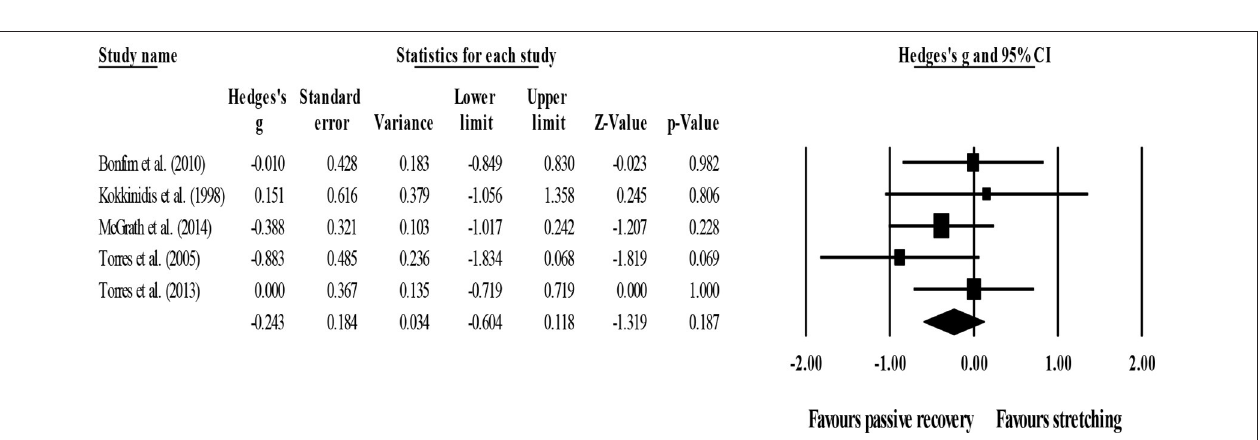
FIGURE 7 | Forest plot denoting 24-h post-exercise delayed onset of muscle soreness (DOMS) in participants that completed passive recovery (control conditions) protocols. Values shown are effect sizes (Hedges’s g) with 95% confidence intervals (CI). The size of the plotted squares reflects the statistical weight of each study. The black diamond reflects the overall result. Note: positive values denote that passive recovery protocols did not allow participants to recover their basal DOMS level (i.e., 0.00 in the figure).